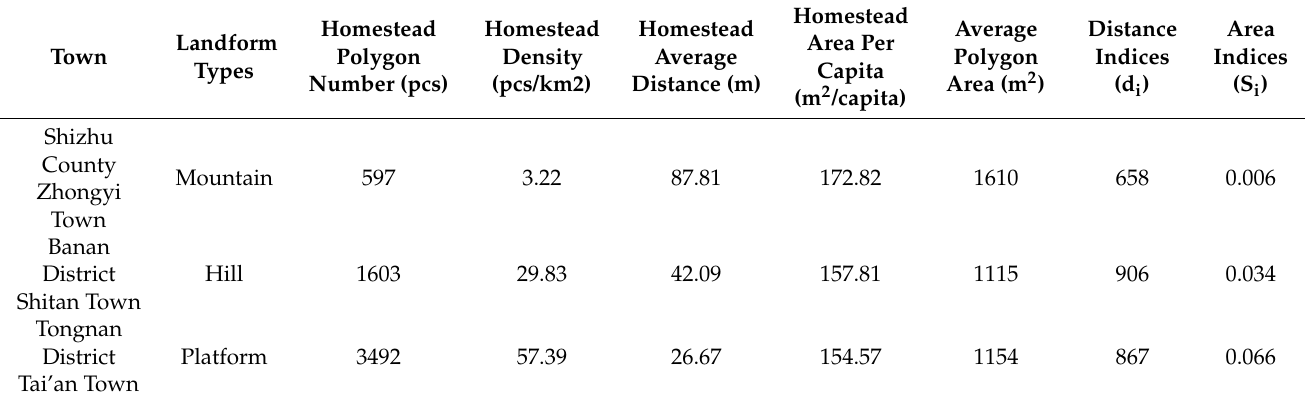
Table 5. Spatial distribution and land use characteristics of homesteads with different landform types.